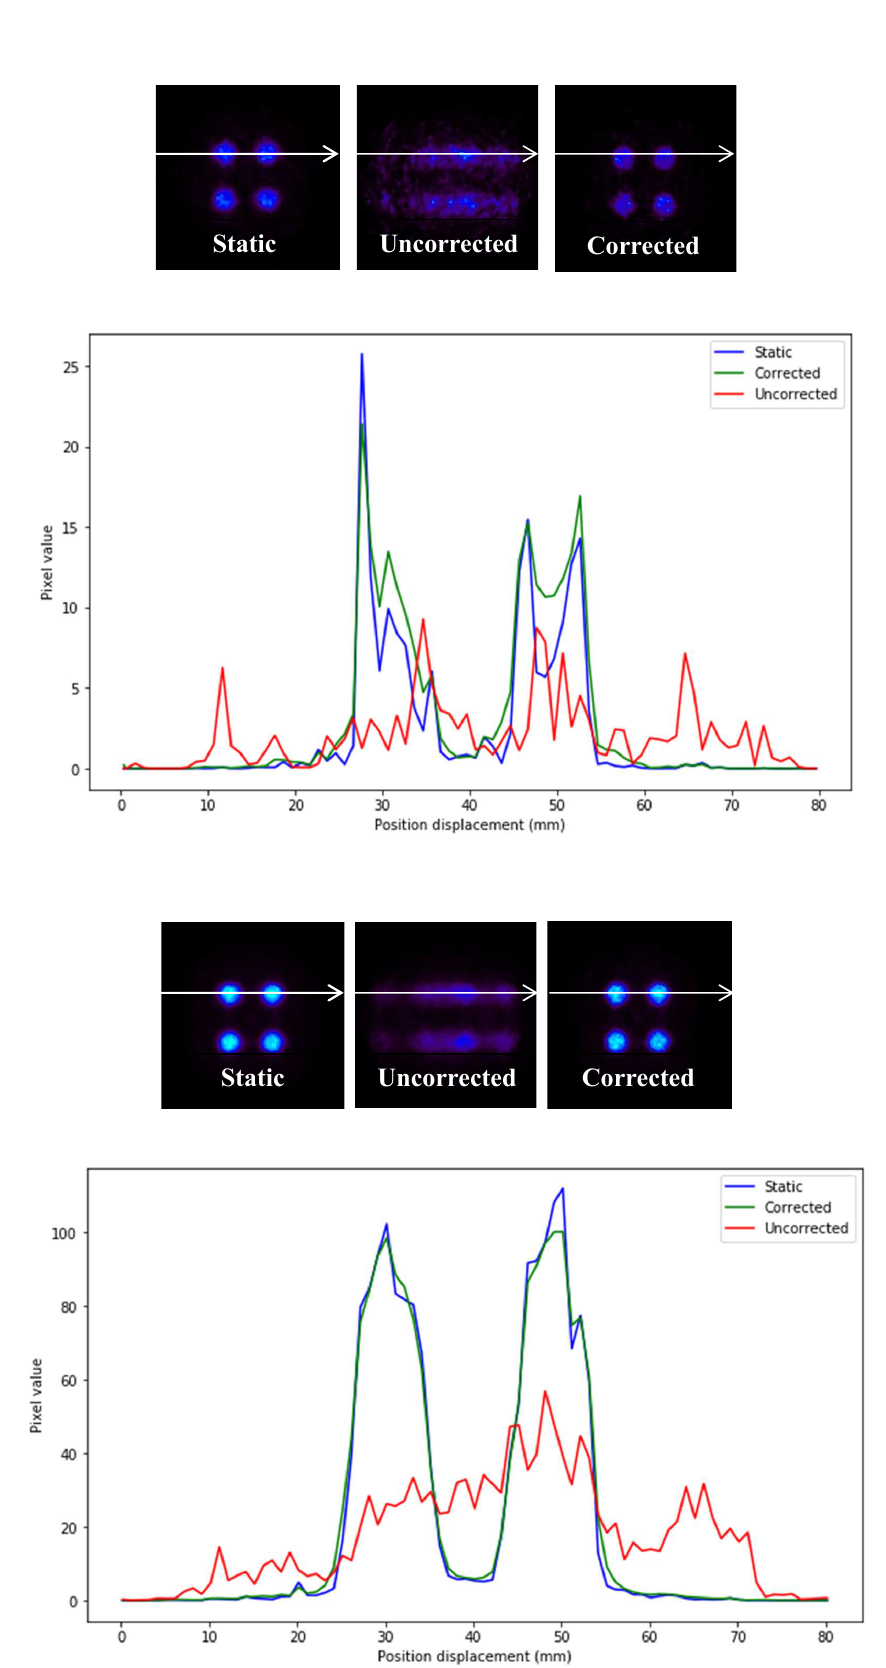
Figure 7. Static image, uncorrected and corrected together with their profiles ( below ) of two ex- periments of different activities. ( Up ): images and profiles of a low-range activity (0.0125 MBq). ( Below ): images and profiles of a high-range activity (0.1 MBq). The white line indicates the profile in the